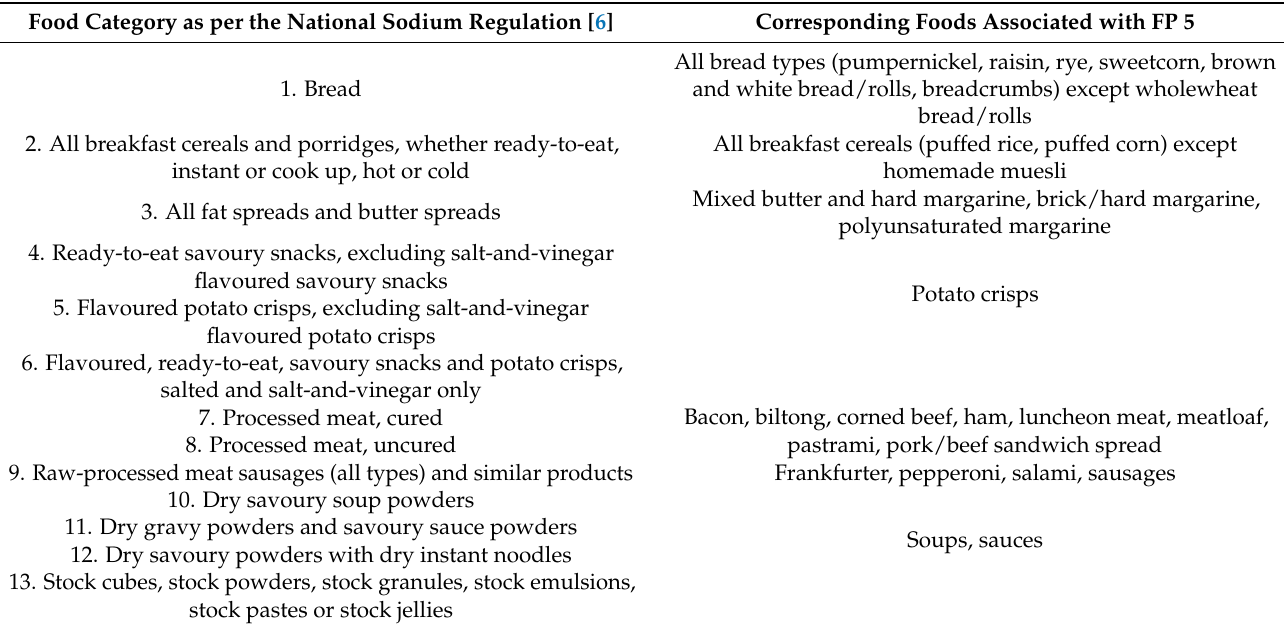
Table 7. Comparison between the food categories targeted by the national sodium regulation and foods associated with FP 5. Food Category as per the National Sodium Regulation